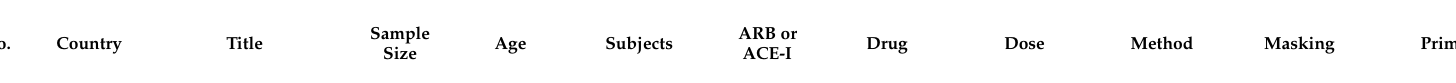
Table 1. Ongoing RCTs to confirm the therapeutic effect of ARB and ACE-I for